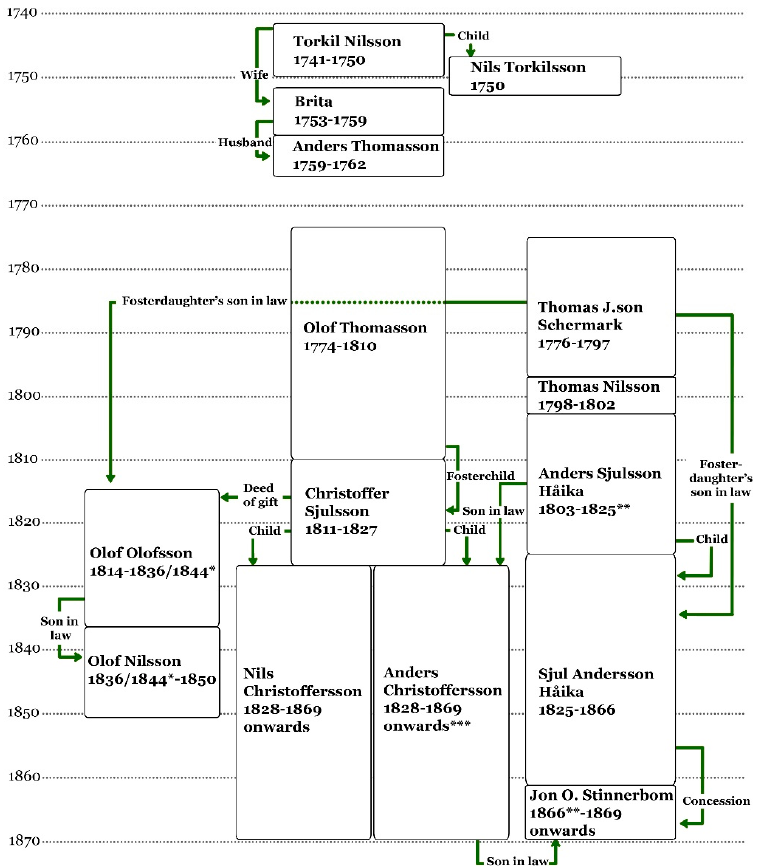
Figure 3. Taxpayers in Gijrejaevrie taxation land, 1740–1869, and their relationships. The figure shows names and kin linkages for all people liable for tax in Gijrejaevrie from 1740 to 1869. Starting at the top of the figure, the boxes indicate the tax payment period. The dates under the names state the